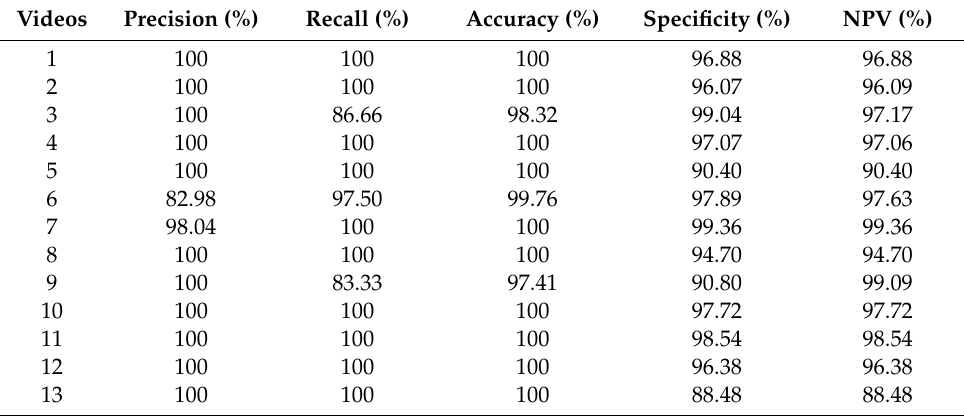
Table 1. Performance evaluation for 13 fall video